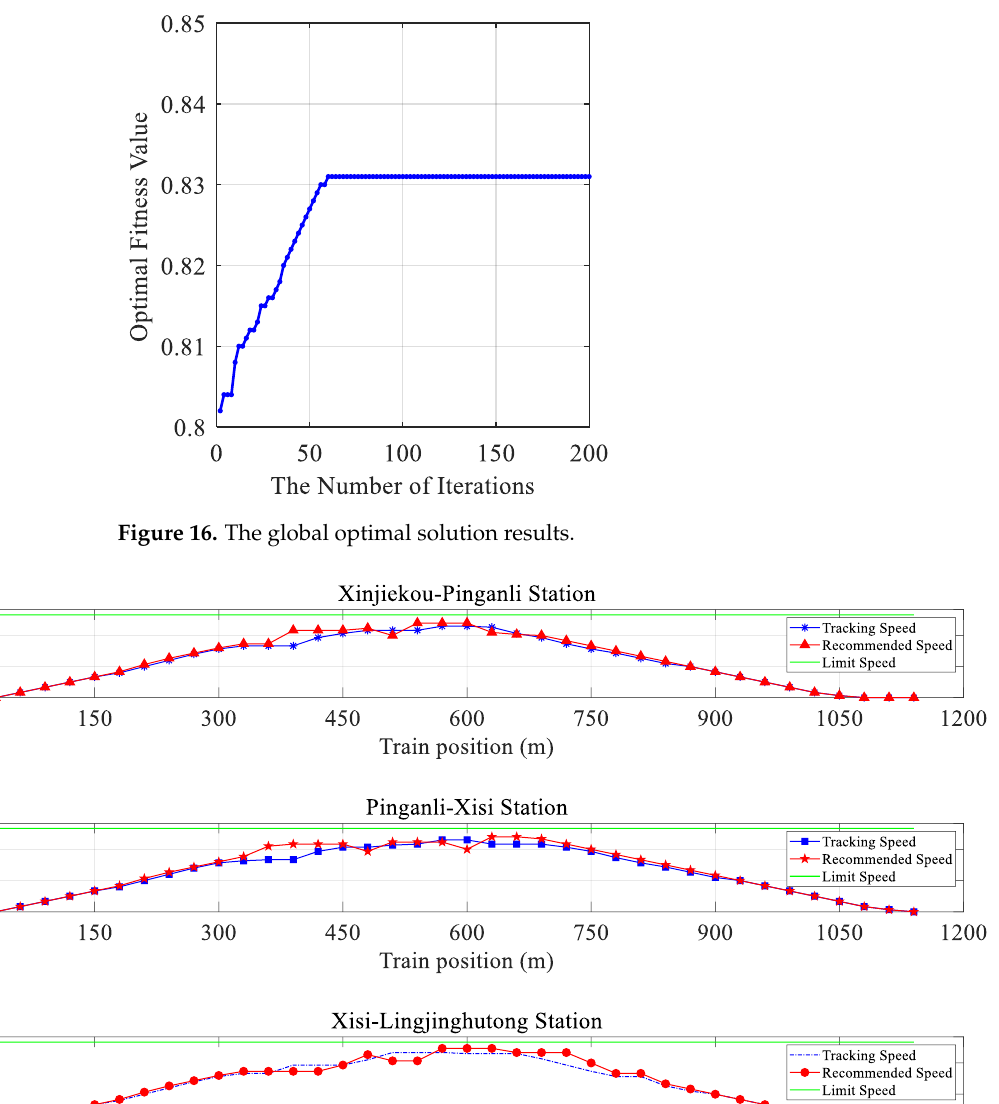
Figure 17. The speed and operating condition conversion points among the four stations.